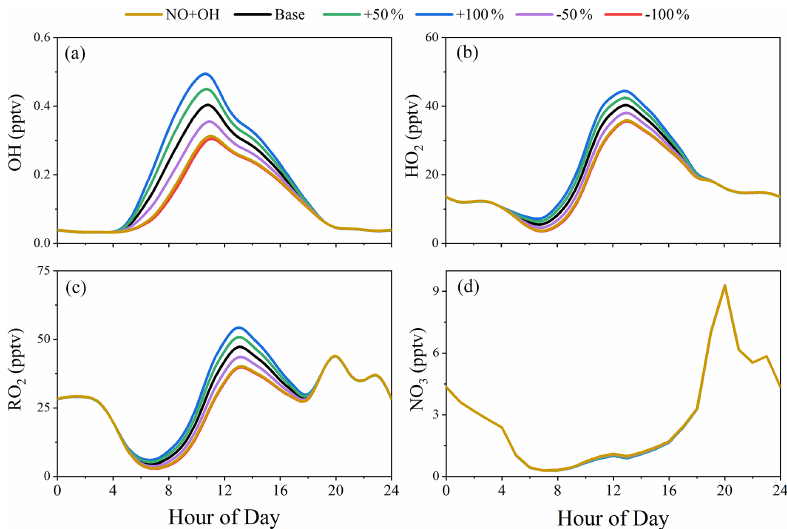
Figure 10. Simulated concentrations of (a) OH, (b) HO 2 , (c) RO 2 , and (d) NO 3 . Different colored lines show results in different scenarios. NO + OH: only with the homogeneous source. Base: constrained by the observed HONO. + 50%: constrained by the observed HONO × 1.5. + 100%: constrained by the observed HONO × 2. − 50%: constrained by the observed HONO × 0.5. − 100%: constrained by HONO =